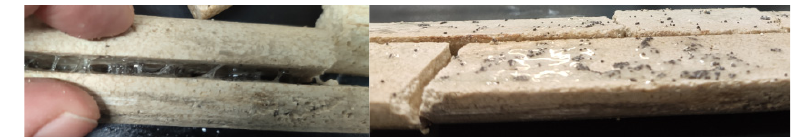
Figure 12. Gelation of chemical agent on the face of the fractured core after experiment.